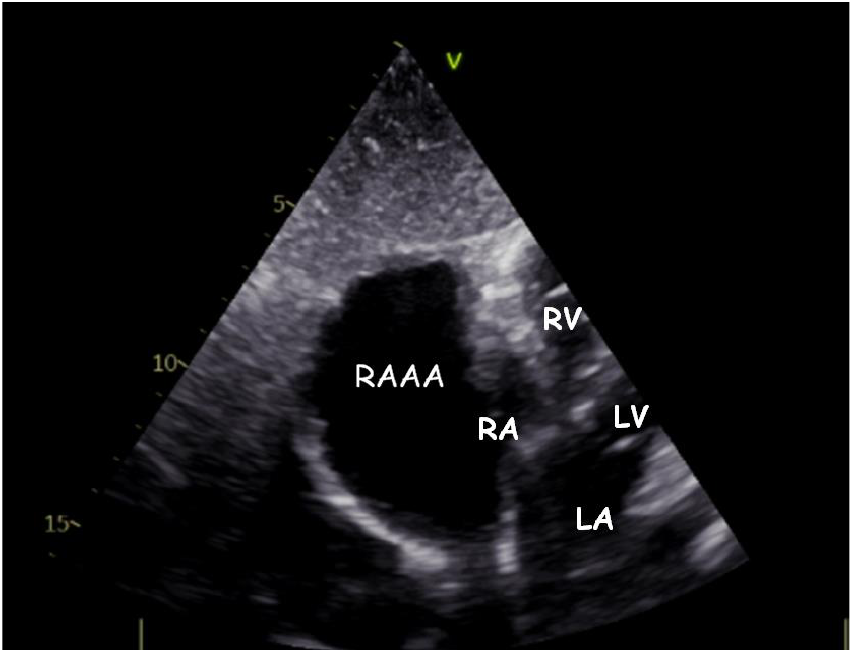
Figure 3. Transthoracic echocardiogram. Modified subcostal view showing the gigantic RAAA ten years later.